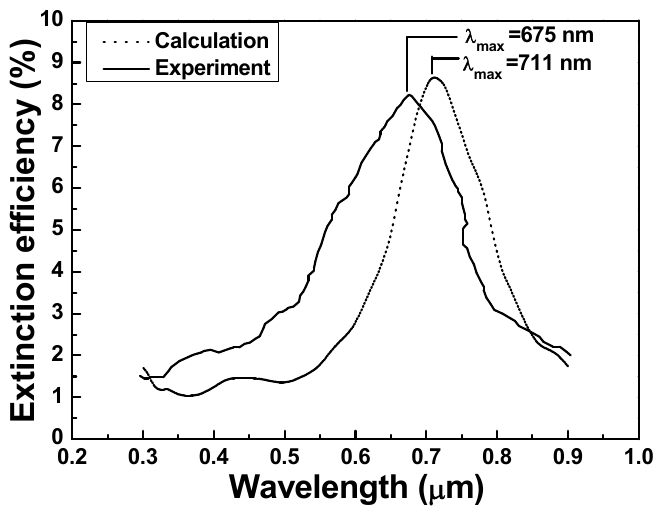
Figure 6. Extinction spectra of experiment and calculation with 1.43 refractive index substrate.